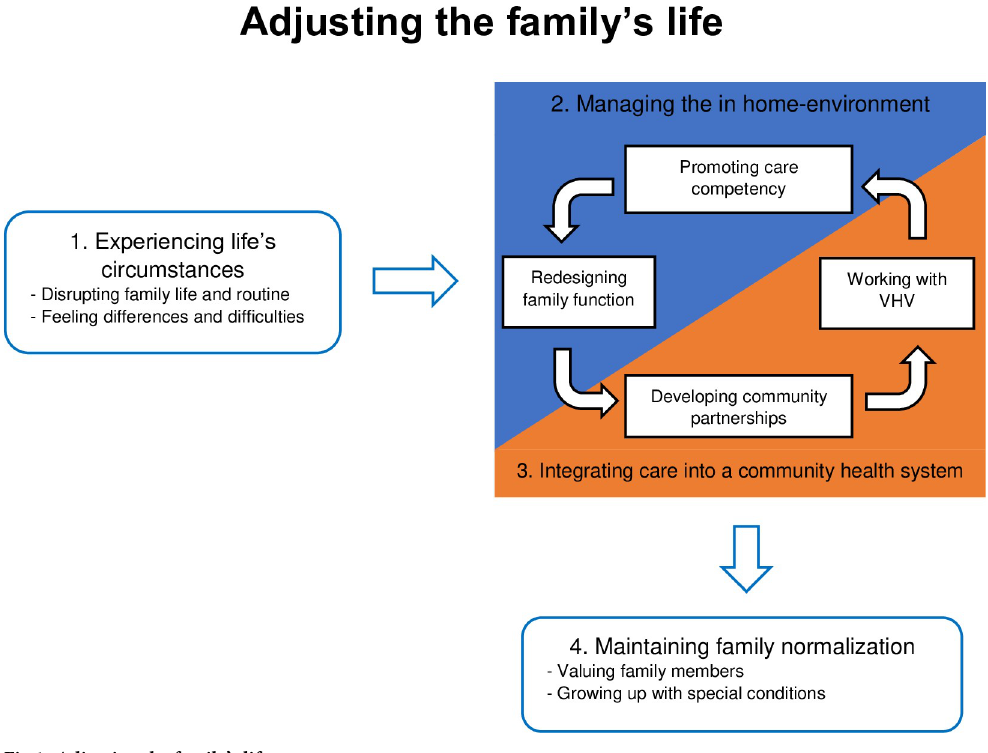
Fig 1. Adjusting the family’s